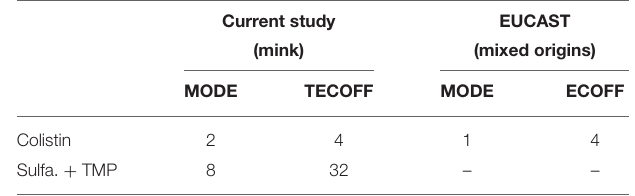
TABLE 5 | Pseudomonas aeruginosa isolated from mink—tentative ECOFFs and modes of MIC wildtype distributions and the official ECOFF from EUCAST.